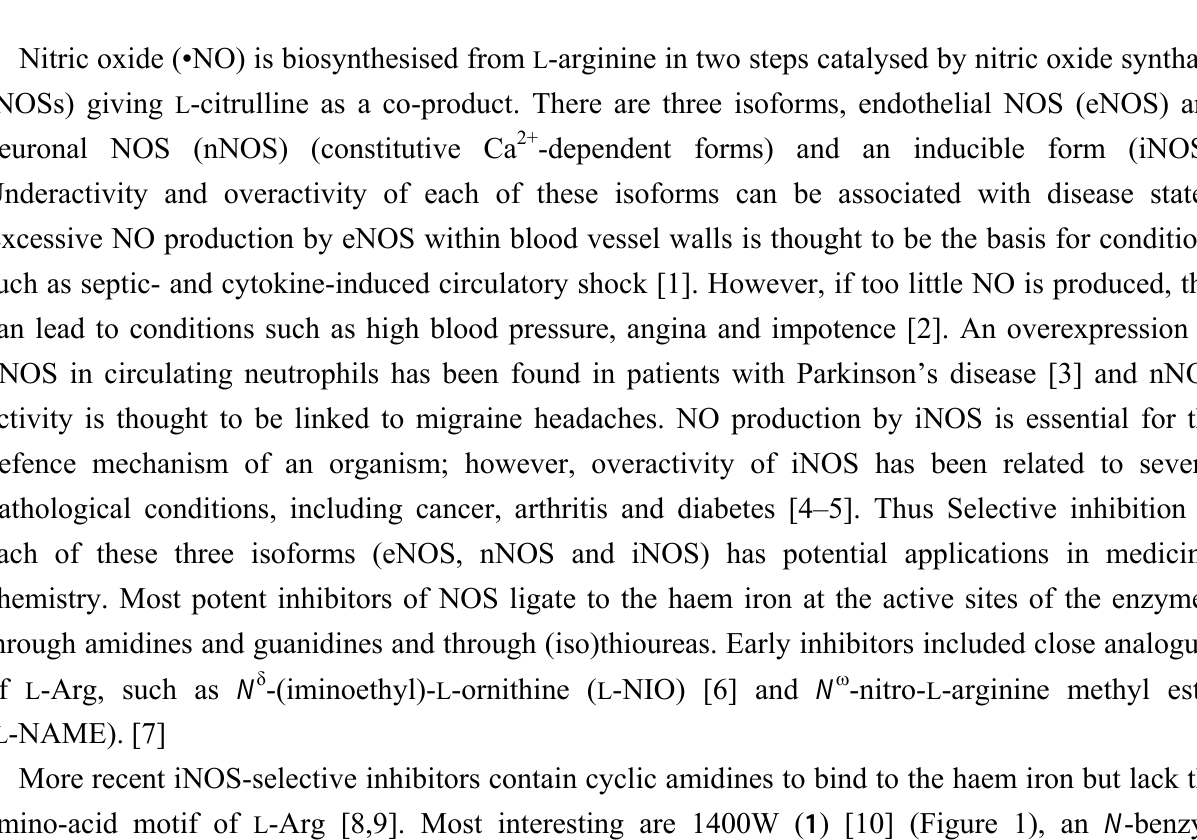
Figure 1. Structures of the iNOS-selective inhibitor 1400W 1 , the nNOS-selective lower homologue 2 and the iNOS stimulators 3 and 4 . R = 3-NH